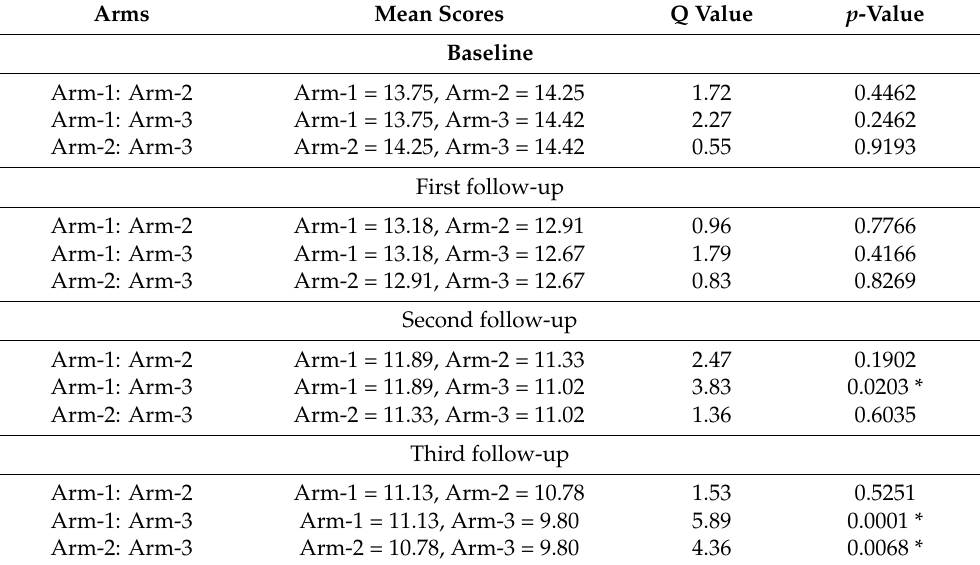
Table 4. Pairwise comparison of HRDS scores between the treatment arms from baseline to first, second and third follow-ups (Tukey’s HSD).